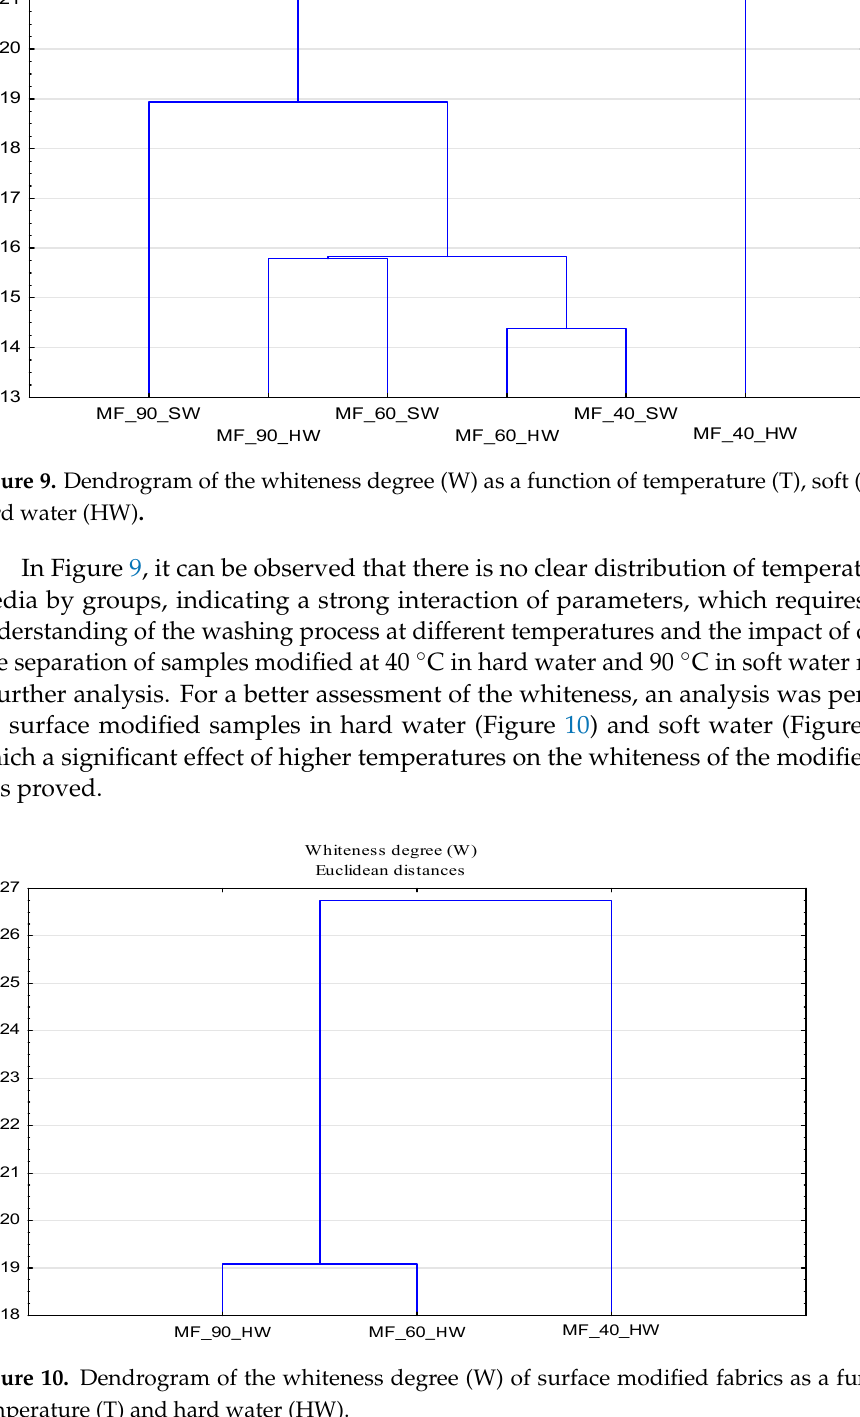
Figure 11. Dendrogram of the whiteness degree (W) of surface modified fabrics as a function of temperature (T) and soft water (SW). The washing process of reference cotton fabrics (F) and modified fabrics (MF) was performed with stain donors to evaluate the action of greying inhibitors, CMC, CMS and their mixture. The degree of whiteness (W) of cotton fabrics was evaluated before and after modification (F and MF), and after the 1st cycle of washing (F1, MF1) of the cotton fabrics with stain donors. The potential of applied polymers in inhibiting soil deposition, i.e., their transfer from the bath to the clean reference and modified fabrics was assessed, Figure 12 [3].